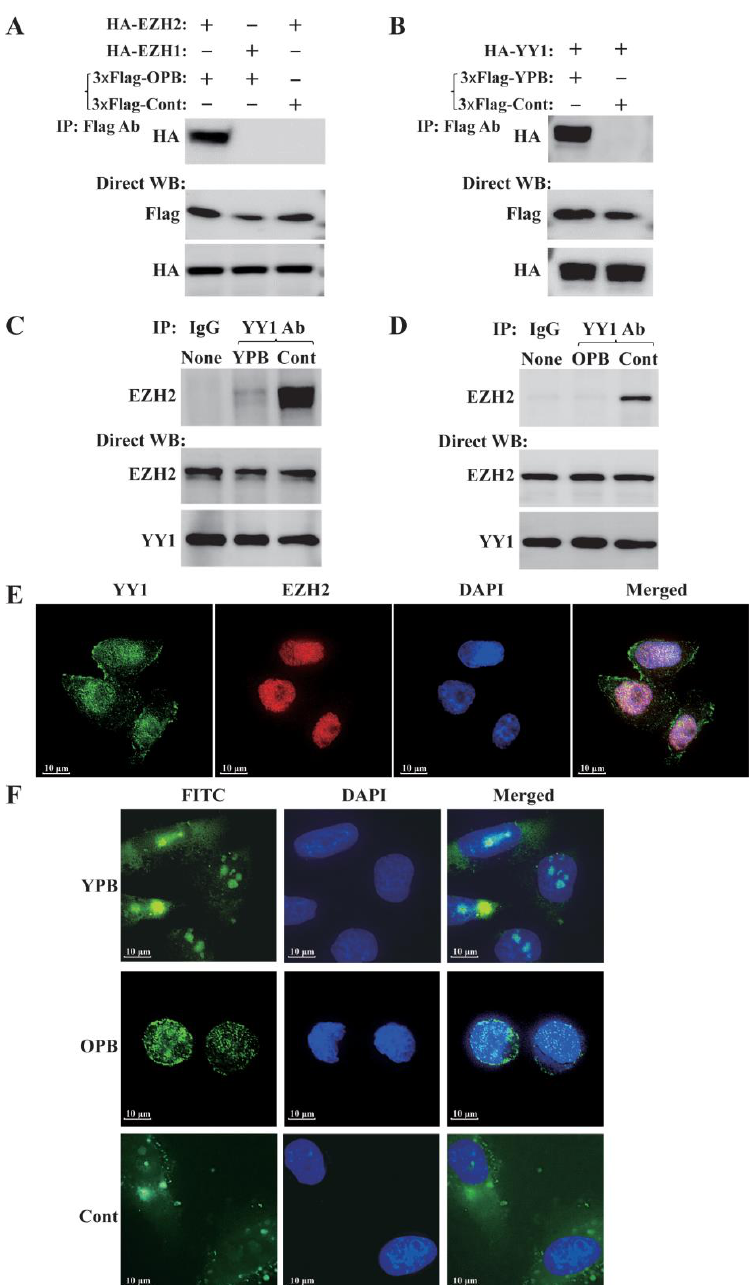
Figure 4. Examination of YPB and OPB peptides in blocking YY1-EZH2 interaction, and their subcellular localization. ( A , B ) Co-IP experiments to determine OPB and YPB interaction with EZH2 and YY1, respectively. In A, 3×Flag-OPB-2A1-EGFP, 3×Flag-Cont-2A1-EGFP expression vectors, and an empty vector were individually cotransfected with HA-EZH2, HA-EZH1 expression vectors, or an empty vector. Cell lysates were co-IPed using Flag antibody followed by Western blot analysis using HA antibody. In B, similar to A but using 3 × Flag-YPB-2A1-EGFP and HA-YY1 in the transfection and co-IP studies. ( C , D ) Examination of YPB and OPB peptides’ effects on YY1-EZH2 interaction. MDA-MB-231 cell lysates were treated by 30 µ M of Cont, OPB, and YPB peptides for 4 h, followed by co-IP using 2 µ g of normal IgG, YY1, and EZH2 antibodies. The co-IPed samples were analyzed by Western blot using YY1 and EZH2 antibodies to evaluate the effects of YPB ( C ) and OPB ( D ) peptides on YY1-EZH2 interaction. ( E ) Examination of YY1 and EZH2 colocalization in cells. MDA-MB-231 cells were immunostained by YY1 and EZH2 antibodies. DAPI was used to visualize nuclei. ( F ) Detection of subcellular localization of peptides. MDA-MB-231 cells were treated by 30 µ M of Cont, OPB, and YPB peptides for 48 h, followed by DAPI staining. The peptides were all N-terminal FITC-labeled and thus could emit green